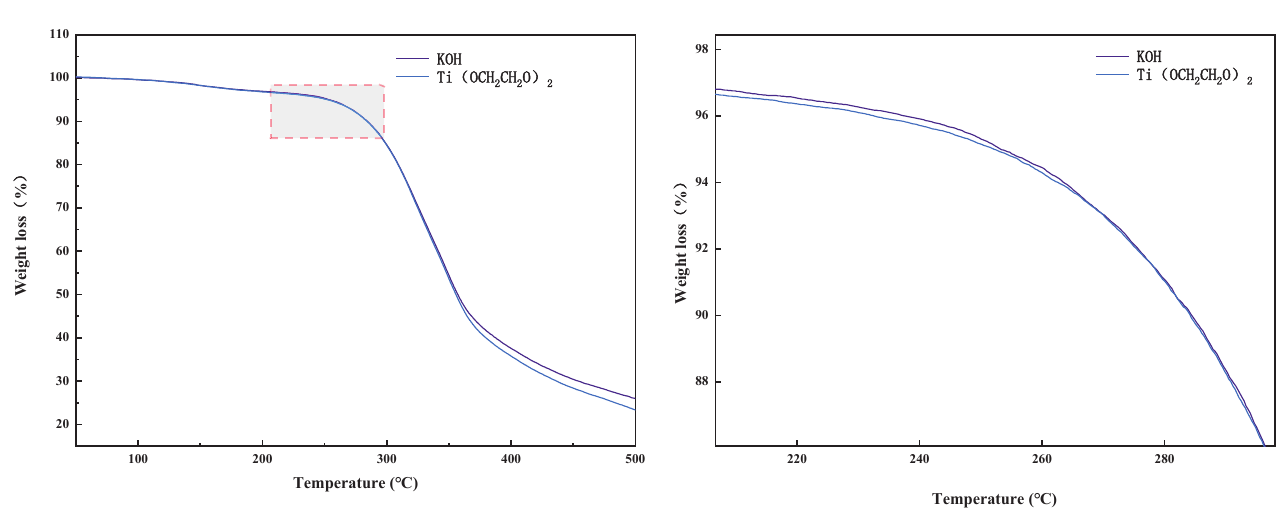
Figure 13. TG analysis of the regenerated polyurethane foam. Thermogravimetric weight can reflect the relationship between the polyurethane foam mass and temperature. The decomposition of polyurethane foam is generally divided into three stages [23]: the first stage is the evaporation of free water from the surface of the polyurethane foam, which is usually not evident in this stage because of the low free water content in polyurethane foam itself; the second stage is the breakage of the hard